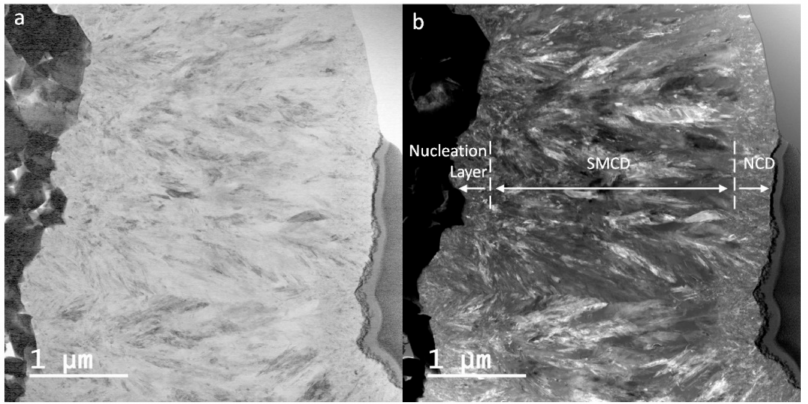
Figure 3. Transmission electron microscopy characterization of a multilayer diamond coating identi- cal to the one used for the end mills in ( a ) bright-field and ( b ) dark-field